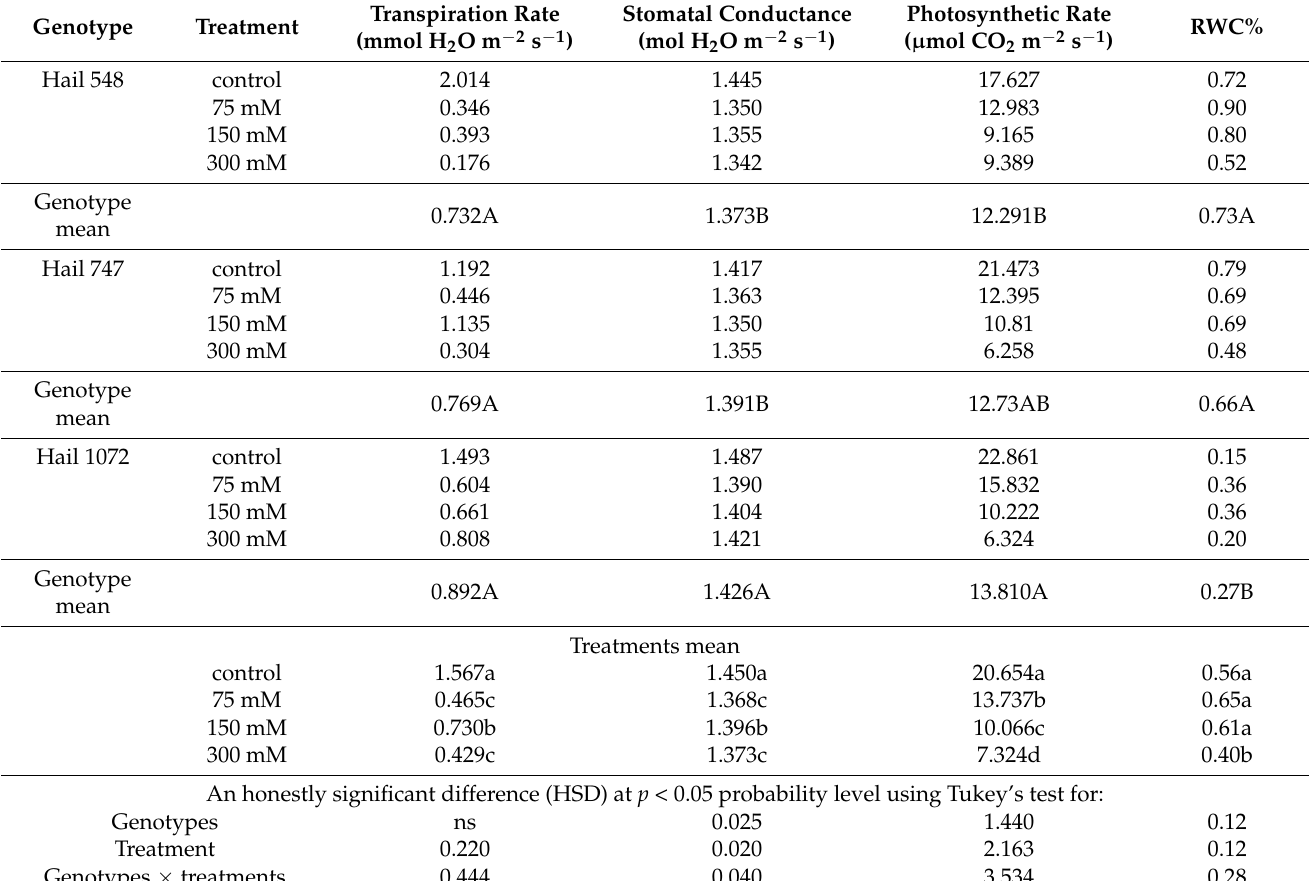
Table 5. Transpiration rate, stomatal conductance, photosynthetic rate, and relative water content (RWC) for three Hail landraces under four NaCl stress treatments. Values are the mean of four replications. According to Tukey’s test, different letters within the same columns indicate significant differences ( p < 0.05). The higher cases are the differences among genotypes, and the lower cases are the differences among treatments’ mean. ns: means not